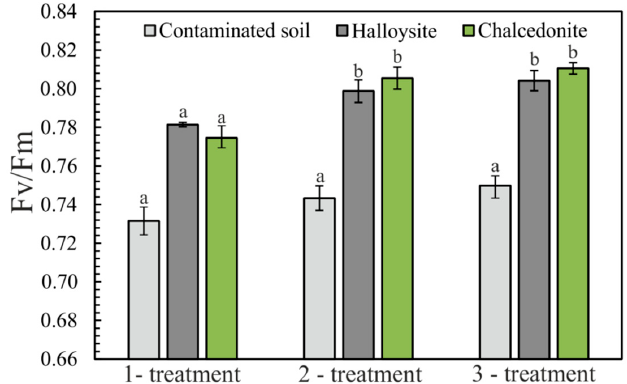
Figure 6. Leaf greenness index (SPAD). Different letters above the columns indicated significant difference at p < 0.05.